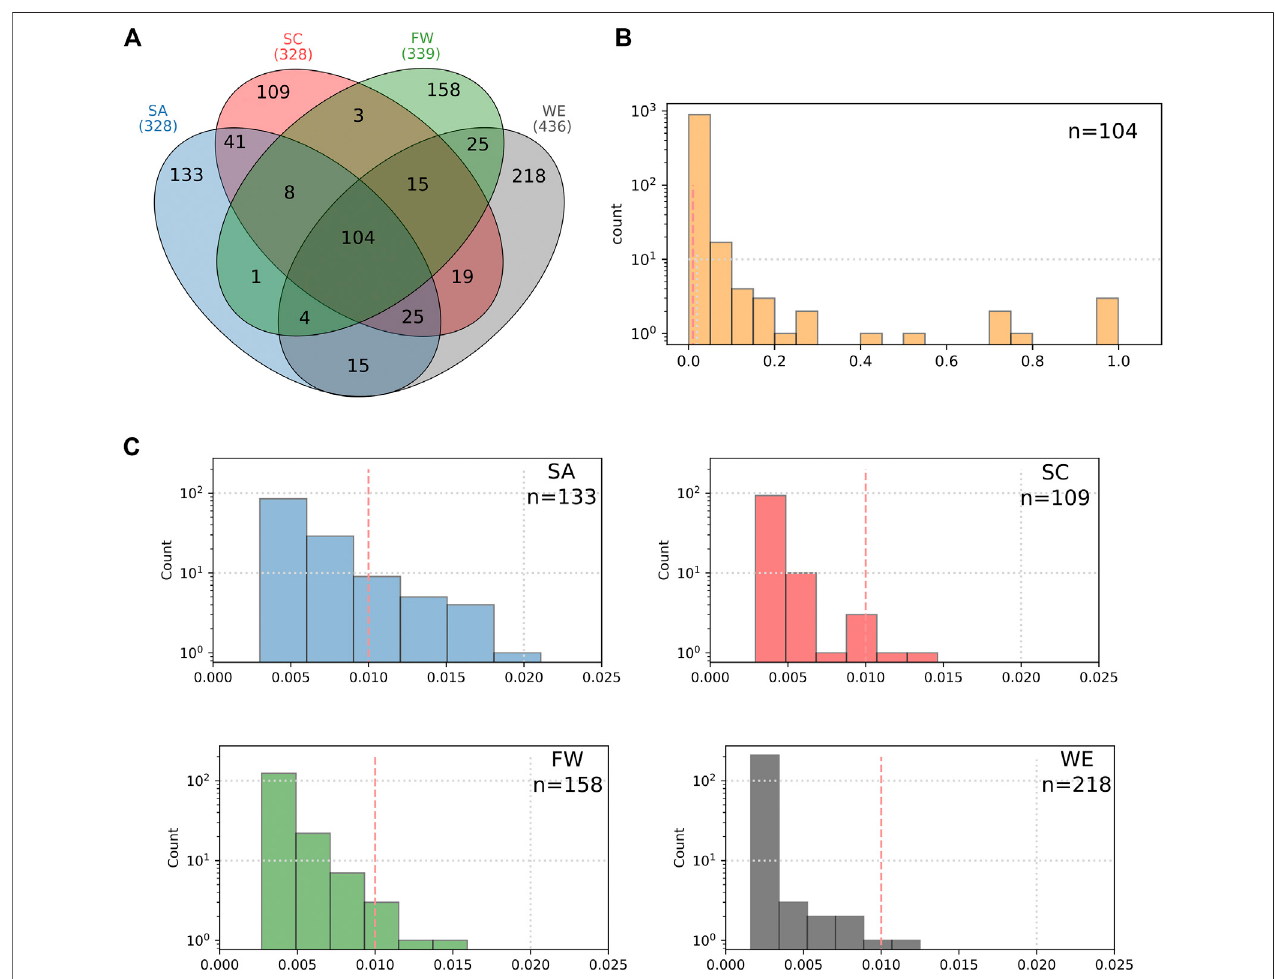
FIGURE 6 | Characterization of the HI-vars in clusters SA, SC, FW, and WE. (A) The Venn diagram shows the overlap between the clusters for these variants. Distribution plots of the frequencies of the common variants between the four clusters (B) and for the unique variants found in each sub-population (C) .